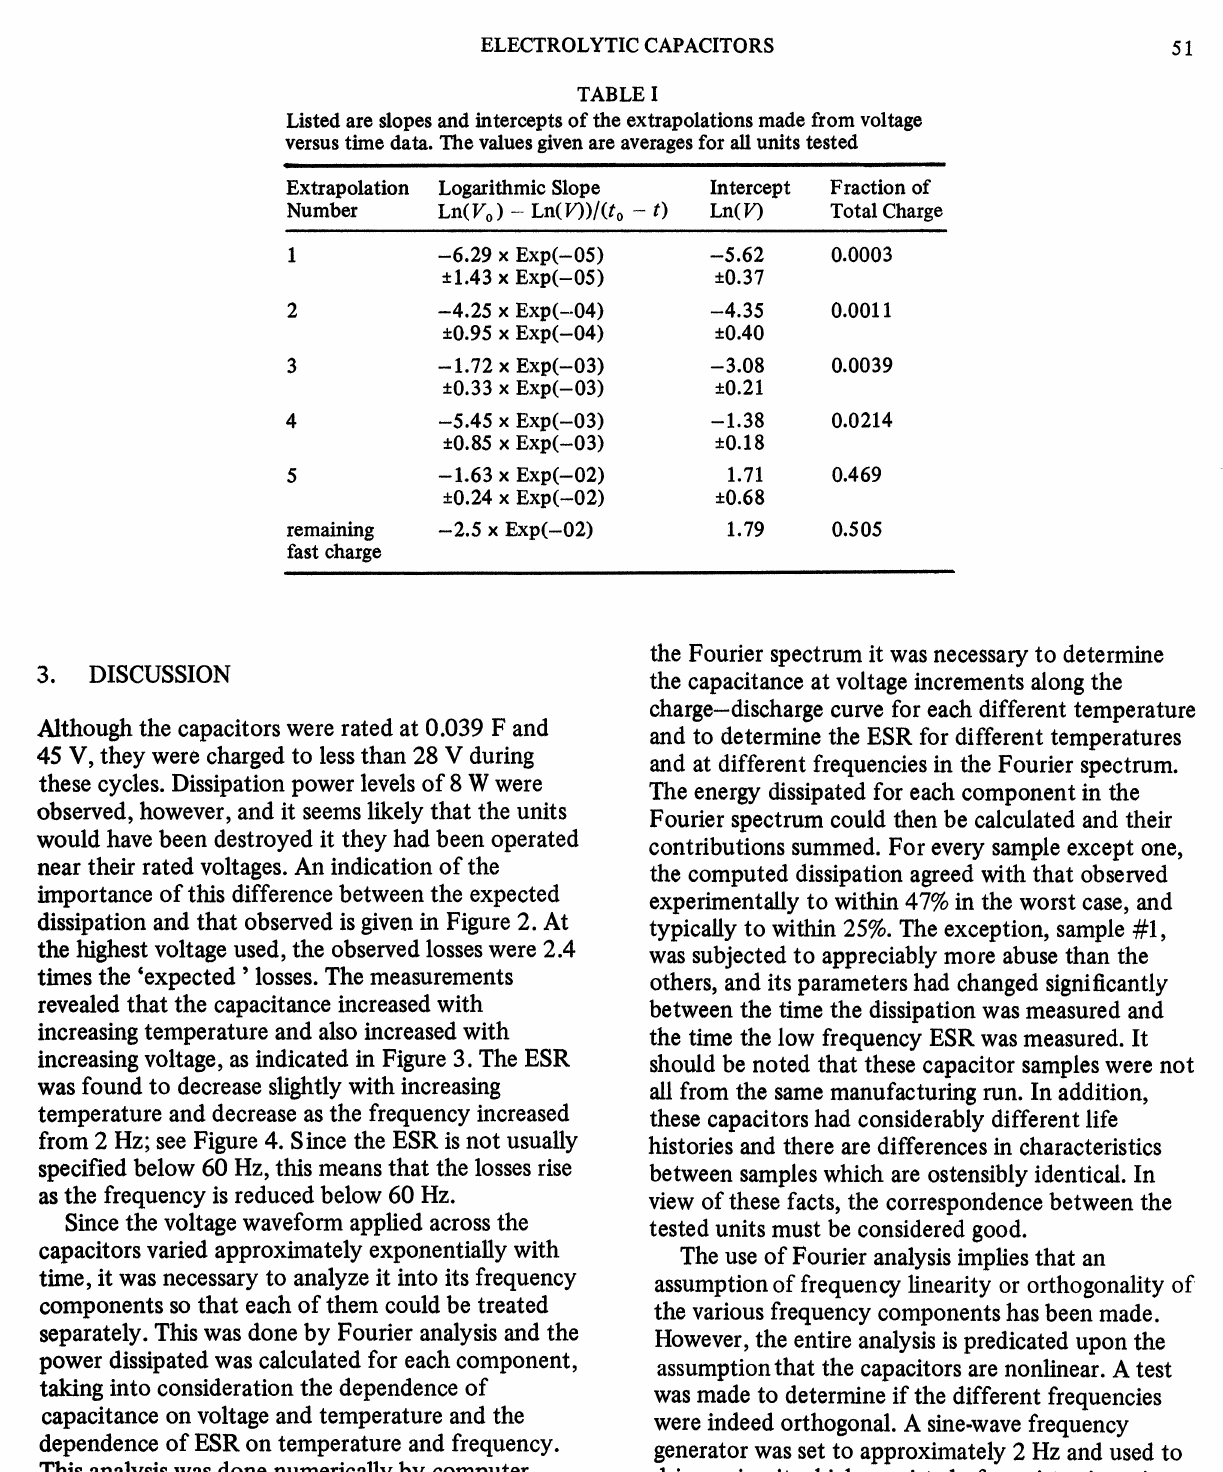
Listed are slopes and intercepts of the extrapolations made from voltage versus time data. The values given are averages for all units